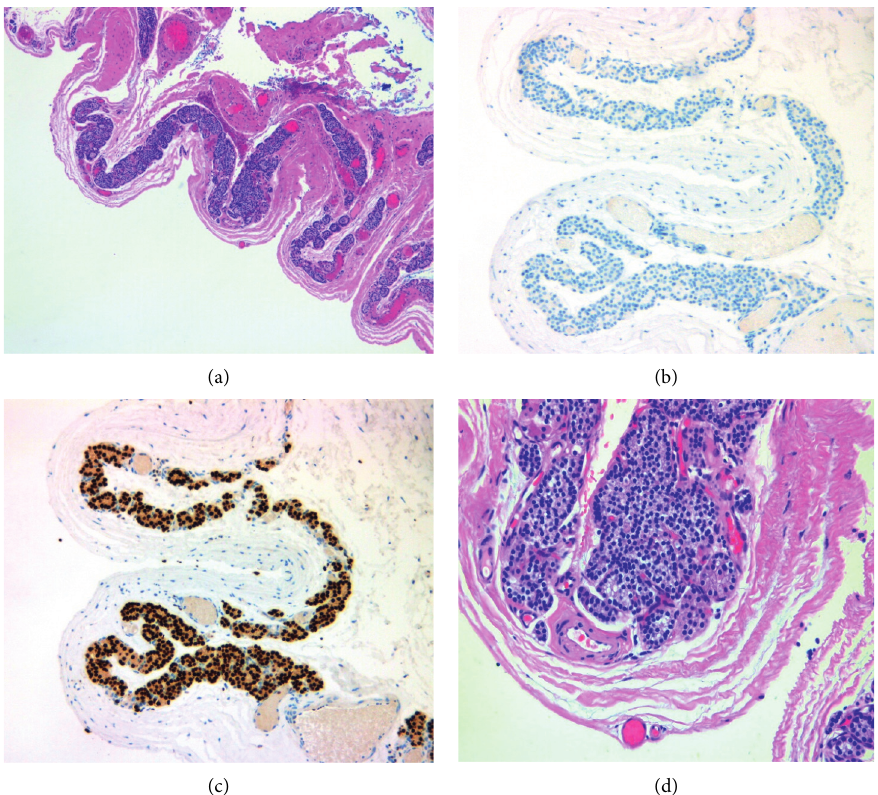
Figure 2: Histological analysis of surgical specimen. (a) Fibroconnective tissue with associated parathyroid tissue lining cystic space. (b) Parathyroid cyst cells staining negative for TTF-1. (c) Parathyroid cyst cells staining positive for GATA-3. (d) Close up visualisation of parathyroid cyst